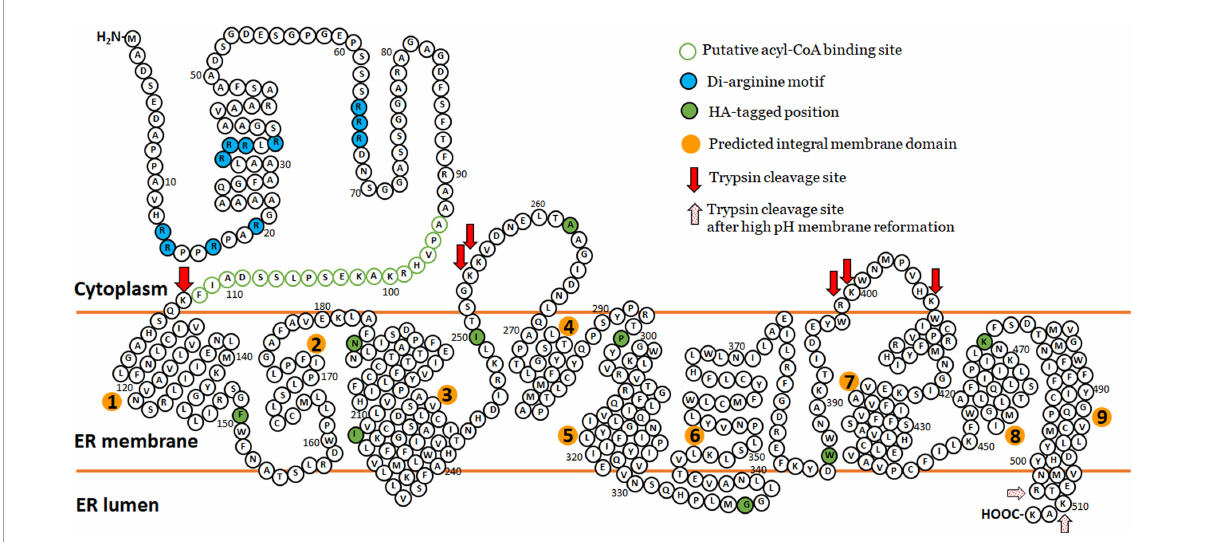
FIGURE8 The predicted topology model of maize ZmL DGAT1. Combining those predicted models of TmPred and AlphaFold and our results from protease protection/internal HA-tag strategy similar to McFie et al. (2010) and high pH reformed membrane compartments (Wu et al., 2003) we speculate nine transmembrane domains (orange circles) between the two termini which create two cytoplasmic loops (at least residue 262–270 and at least residue 398–406), and a C-terminal tail in the lumen (consisting of at least residue 500 to the C-terminus). Our results from the protease digestion of HA 296 suggested these residues around 296 is not exposed into cytosol. The original amino acid sequence of ZmL DGAT1 (XP_008648150) is represented by black circles. HA tag position is represented by black circles filled with green. The putative acyl-CoA binding site is presented by green circles and the putative di-arginine motifs are presented by black circles filled with turquoise. Red and red dotting arrows indicated estimated positions cleavable by trypsin digestion.